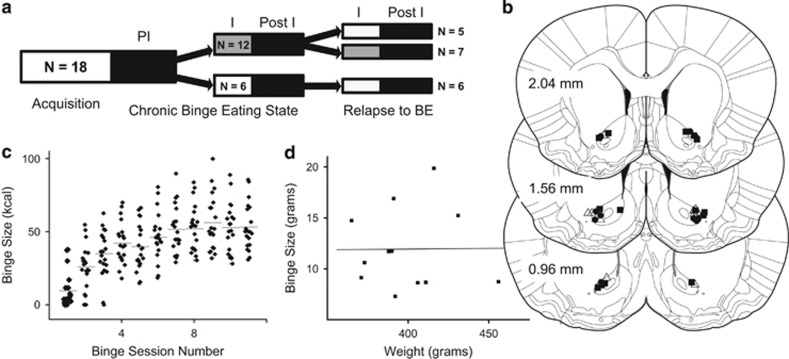
Experimental design and acquisition of the chronic binge-eating state. (a) Experimental design illustrating the behavioral states and corresponding progression of group sizes. White and black boxes denote sessions of no stimulation (sham), whereas gray boxes represent active stimulation. PI, pre-intervention; I, intervention; Post I, Post intervention. (b) Electrode locations displayed on representative coronal plates spanning the anterior–posterior dimension (A–P coordinates shown) using the following group symbol pairs: •, Stim→Stim; ▪, Stim→Sham; Δ, Sham→Sham. (c) Acquisition of bingeing behavior in all 18 animals showing the variation in binge size (kcal) across sessions. Binge sizes are displayed in kcal for comparison with the previously published model. Group averages in each session are shown with horizontal gray line. (d) Plot of binge size (g) versus body weight (g) in the chronic binge-eating state for all animals showing no significant relationship (R=0.0094, P=0.977).